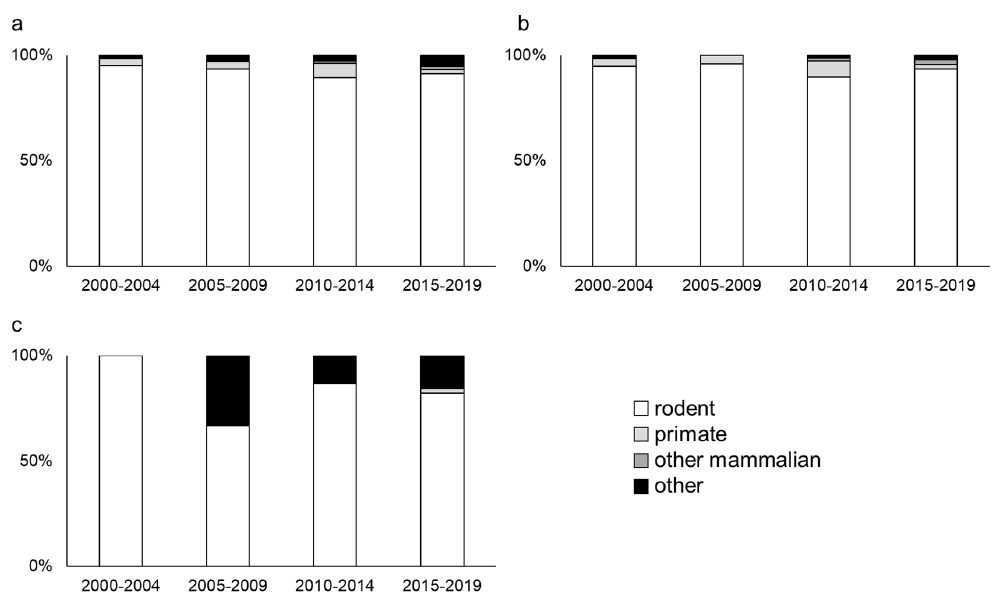
Figure 4. Animal type used for Parkinson’s disease (PD) research. ( a ) The proportion of animal species that are used for research to all types of PD animal models. ( b ) The proportion of animal species that are used for research to neurotoxin models. ( c ) The proportion of the animal species that are used for genetic models.